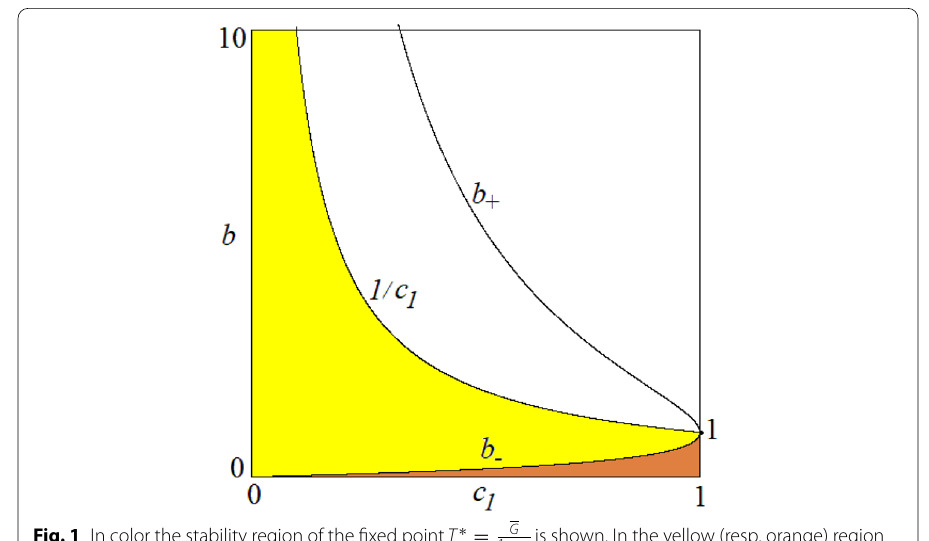
G is shown. In the yellow (resp. orange) region 1 c 1 = −